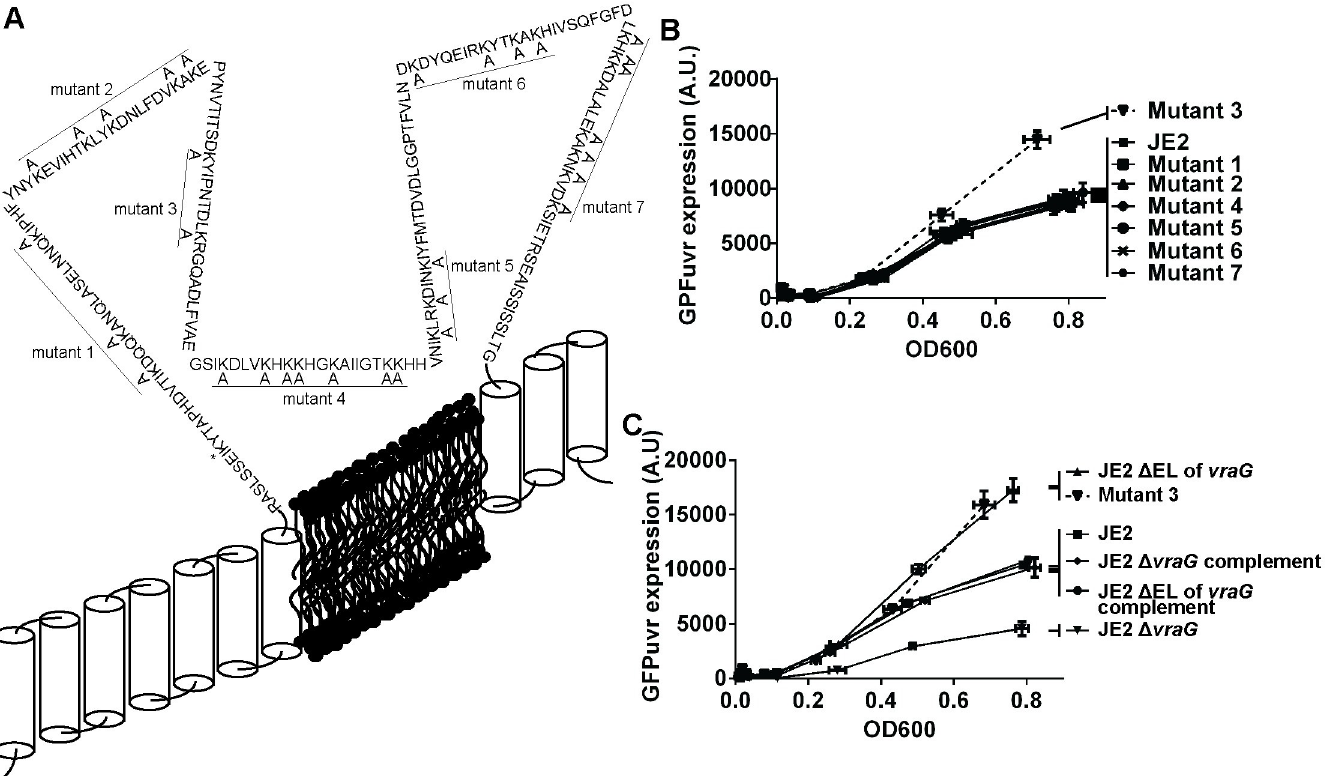
Fig 3. Lysine residue in the EL of VraG is involved in GraS-mediated signaling. (A) Pictorial representation of the VraG membrane structure. VraG is consisted of 10 transmembrane segments, 5 extracellular and 4 intracellular loops. There is one large extracellular loop of ~ 200 amino acids harboring 32 lysine residues while the other extracellular loop is small (7–23 residues). Based on the distribution pattern (densely grouped) of lysine residues in the loop, we divided the EL into seven groups and mutated all the lysines in each group to alanine. They were labeled as mutants 1 to 7 (Table 2). The K317 residue of VraG (marked as asterisk) was not included in the mutagenesis plan as this particular residue was close to a transmembrane domain. (B) , (C) The expression of mprF promoter fused with a GFPuvr reporter. Seven lysine group mutants (B) as well as Δ EL and Δ vraG mutants and their complements (C) with the GFPuvr reporter were monitored by measuring fluorescent intensities (A.U.) and OD 600 as previously described. The data were displayed by A.U.s (y-axis) and OD600s (x-axis) with SDs (error bars) of corresponding values calculated from three biological replicates.